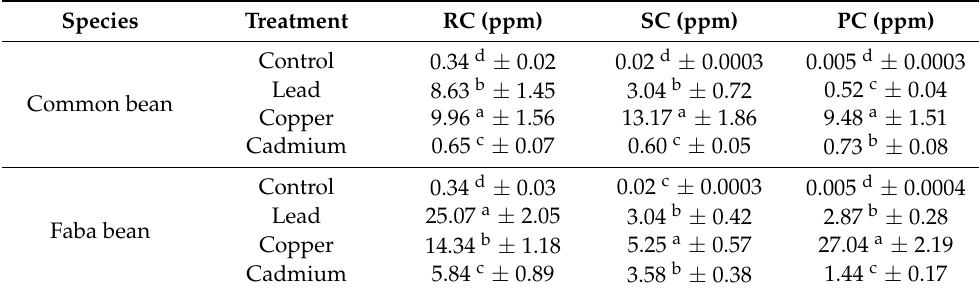
Table 8. Bioaccumulation factor and translocation factor in bean and faba bean plants at pods stage. Species Treatment BAF TF S TF P Common bean